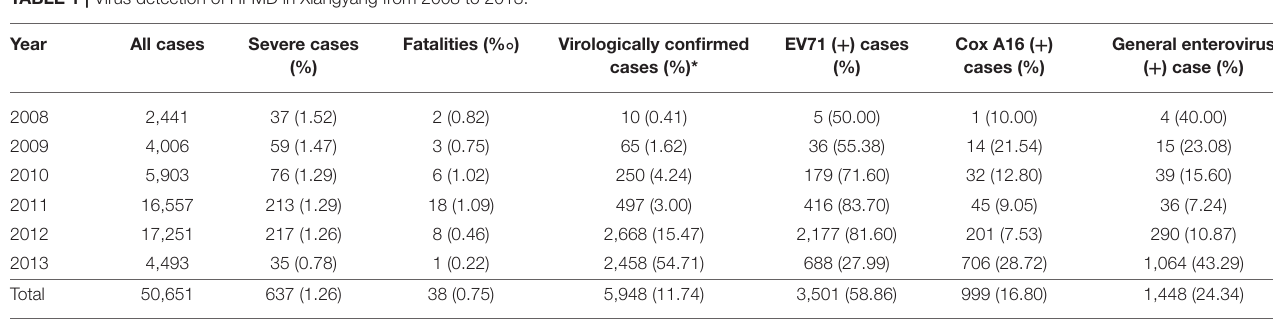
TABLE 1 | Virus detection of HFMD in Xiangyang from 2008 to